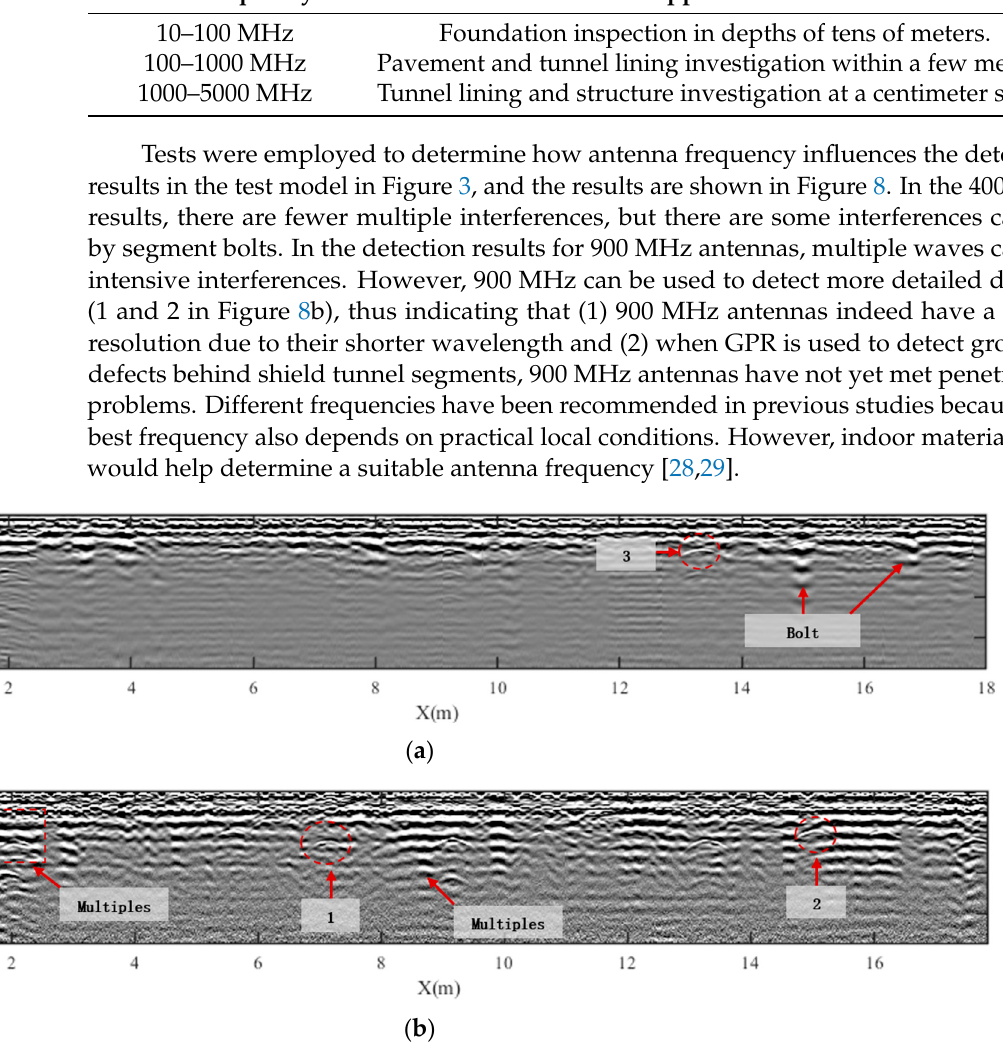
Figure 8. Test results for different antenna frequencies: ( a ) 400 MHz and ( b ) 900 MHz.